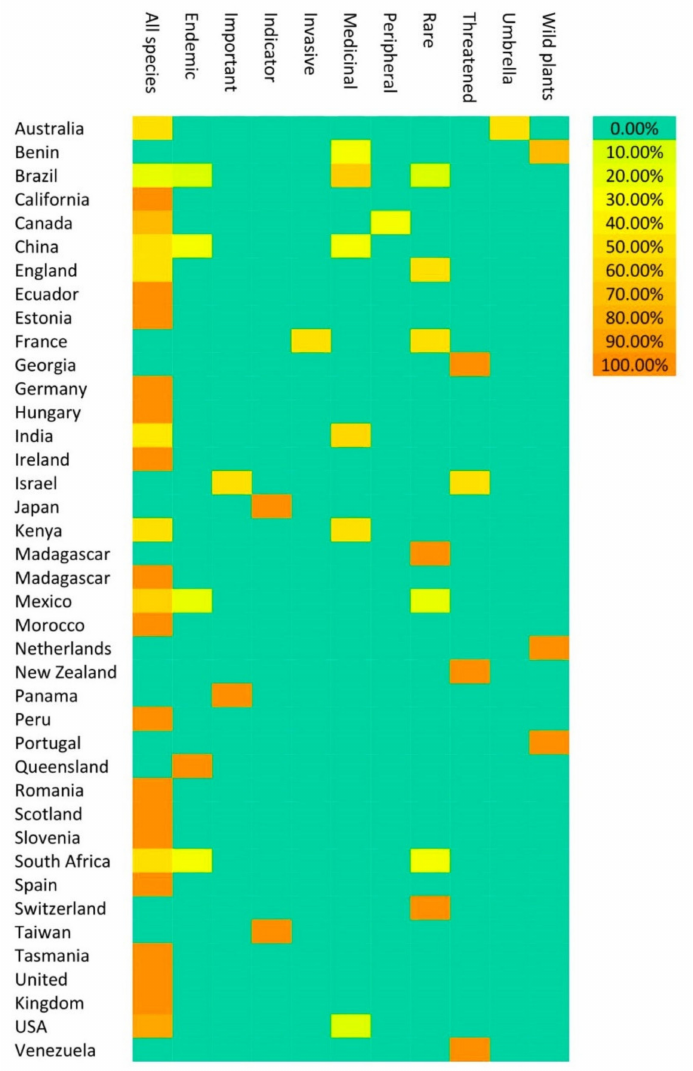
Figure 6. Heatmap diagram showing the relative count of commonly used focal species across